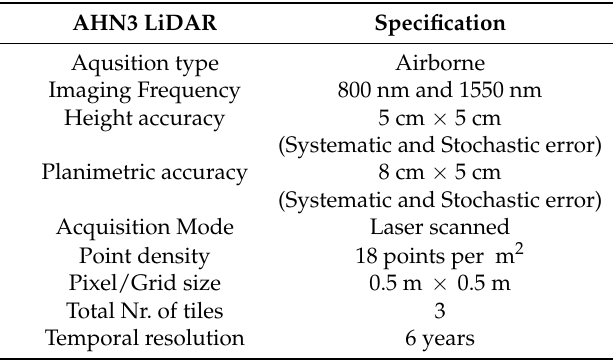
Table 2. AHN3 LiDAR data